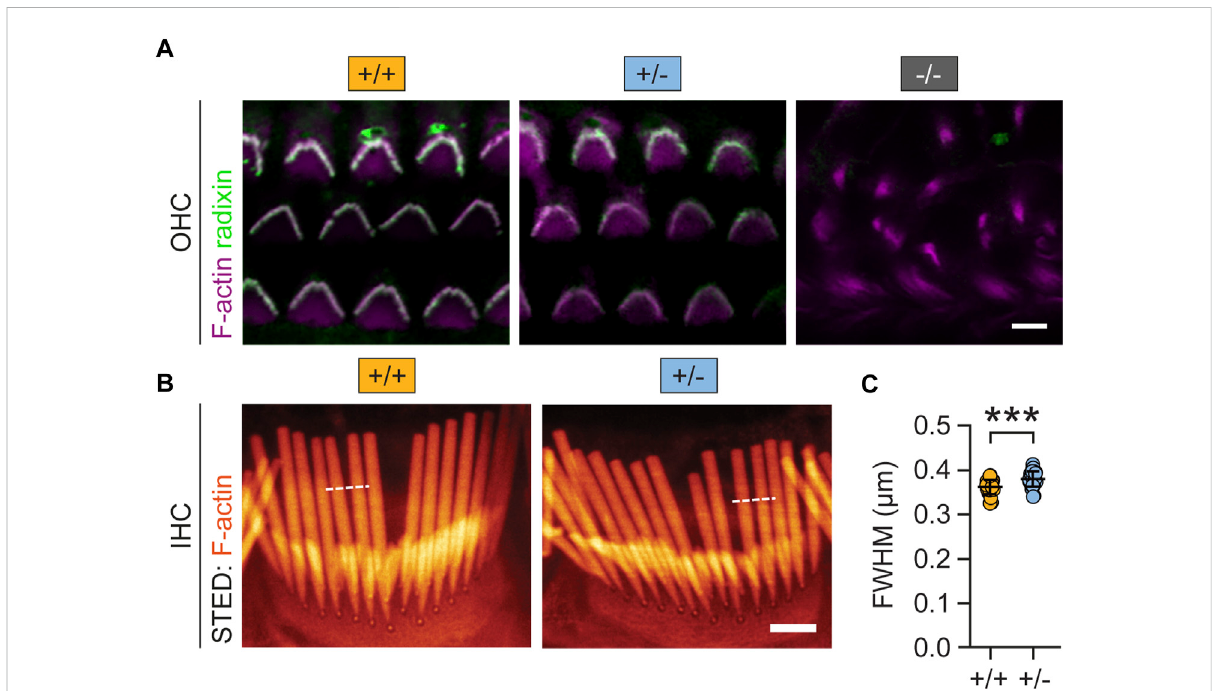
FIGURE 4 Monoalleliclossofrdxmildlyaltersauditoryhaircellstereociliamorphology. (A) Representativeconfocalmicrographsofmousecochlearouter haircell(OHC)stereociliaimmunostained forRdx(green)andF-actin (Tritc-Phalloidin;purple)derivedfromadult(+/+),(+/-)and( − / − ) rdx knockout mice. Rdx is expressed in hair bundles of OHCs. The overall morphology of stereocilia appears comparable between (+/+) and (+/-) but it was severely degenerated in ( − / − ) tissue. (B) Representative super-resolution STED images of phalloidin-labelled (orange) inner hair cell (IHC) bundles, derived from (+/+) and (+/-) mice. (C) Quanti fi cation of full width at half maximum (FWHM) values derived from fl uorescence intensity pro fi les (white dashed lines). Data revealed a small but statistically signi fi cant increase in stereociliar width in rdx (+/-), compared to wildtype (+/+) mice. (+/+): n(stereocilia) = 236, n(IHC) = 29, N = 3; (+/-): n(stereocilia) = 213; n(IHC) = 30, N = 3. Independent Student´s t -test was used to asses statistical signi fi cance. *** p < 0.001. Data represent grand averages per IHC ±